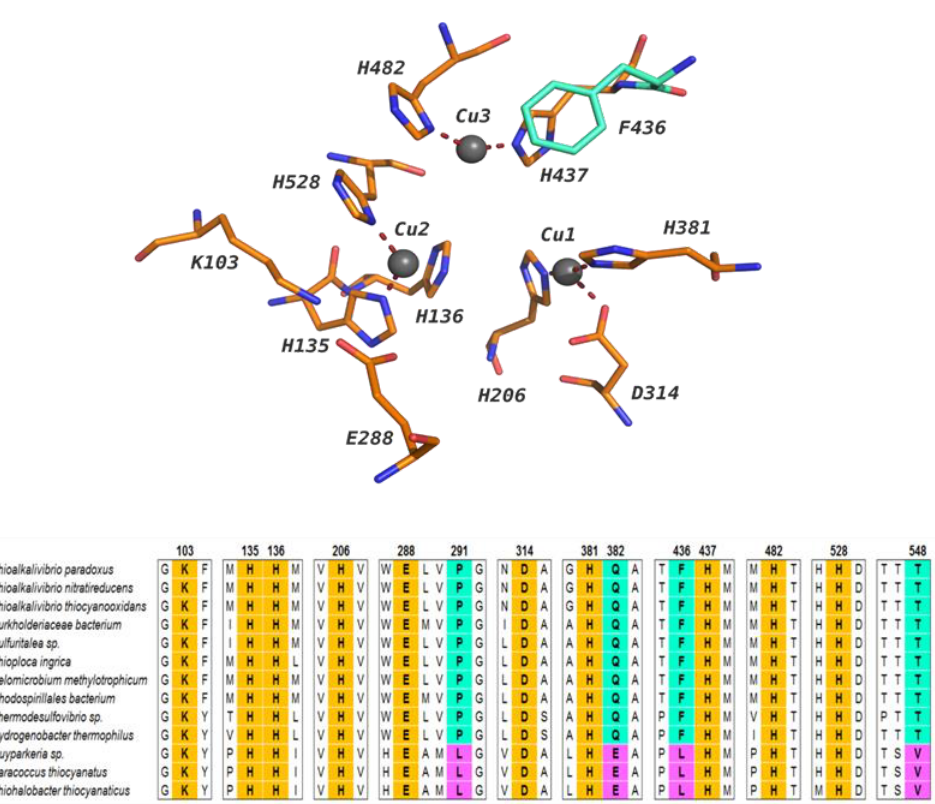
Figure 1. TcDH active center and a consensus TcDHs fingerprint. ( Top ) The amino acid residues are colored by elements, carbon atoms of ten conservative residues and F436 residue are orange and turquoise, respectively. Copper ions are presented in gray spheres. ( Bottom ) The partial multiple sequence alignment of TcDHs from different microorganisms is shown. Ten conservative amino acid residues of the TcDH active center are depicted in orange. The residues in positions 291, 382, and 436 (TcDH numbering) and the C-terminal residue are shown in turquoise and magenta for enzymes with the sequence identity >40% and <40%, respectively.